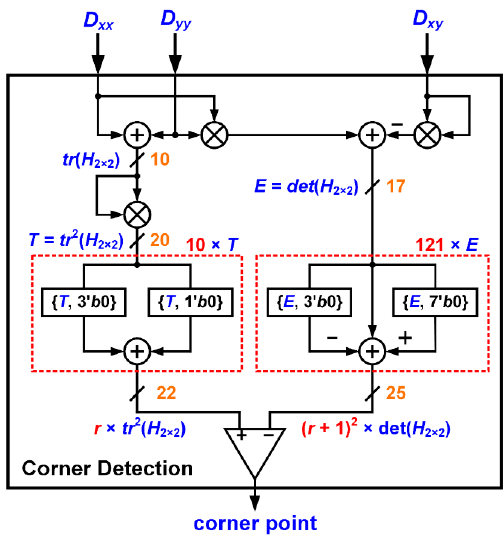
Figure 15. Hardware structure of the corner detection.